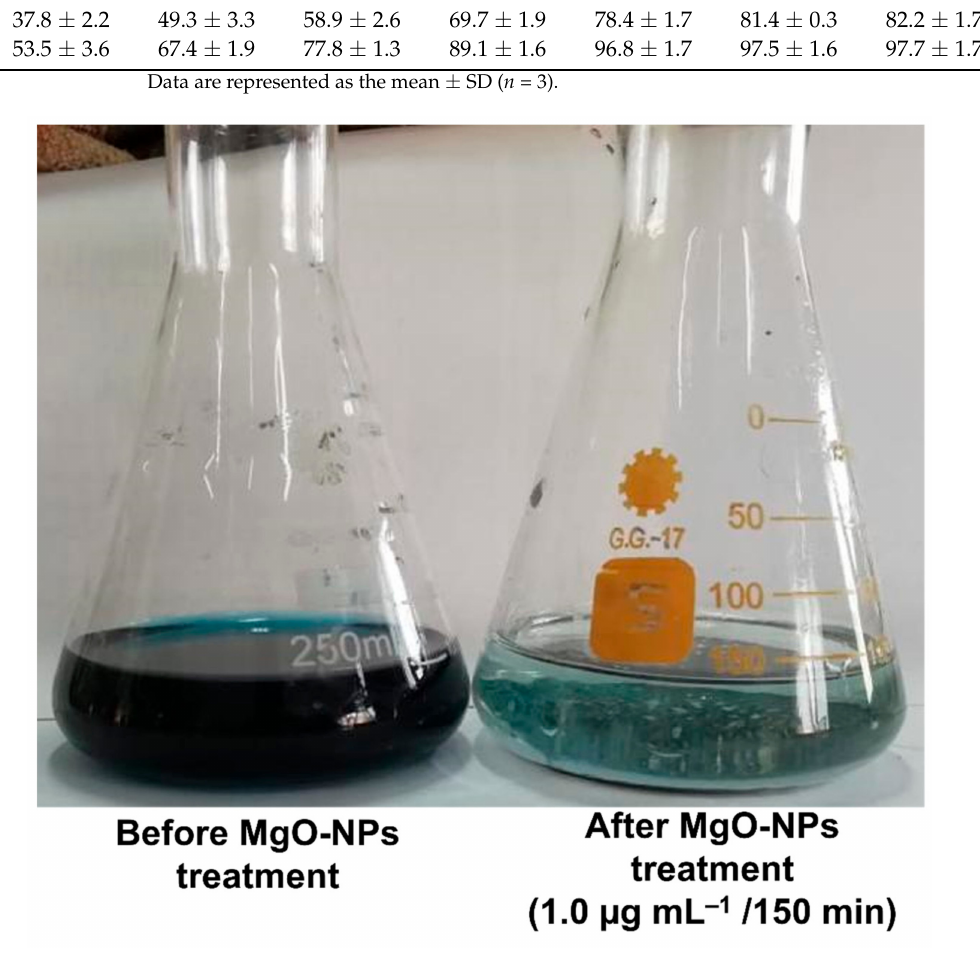
Figure 9. The decolorization of tanning effluent using biogenically synthesized MgO-NPs by A. terreus strain